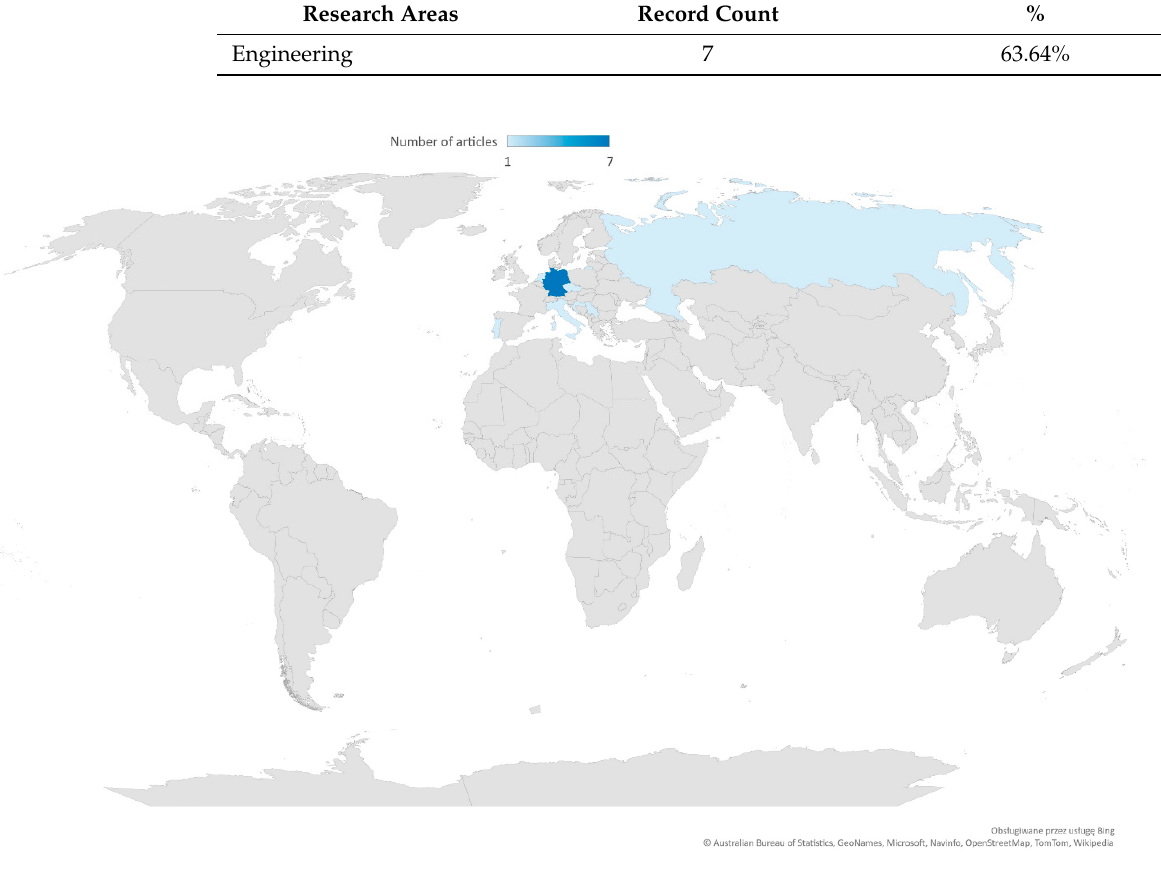
Figure 10. Scientific contribution by country and geographic region related to Logistics 4.0 in the SME sector; Source: own study.